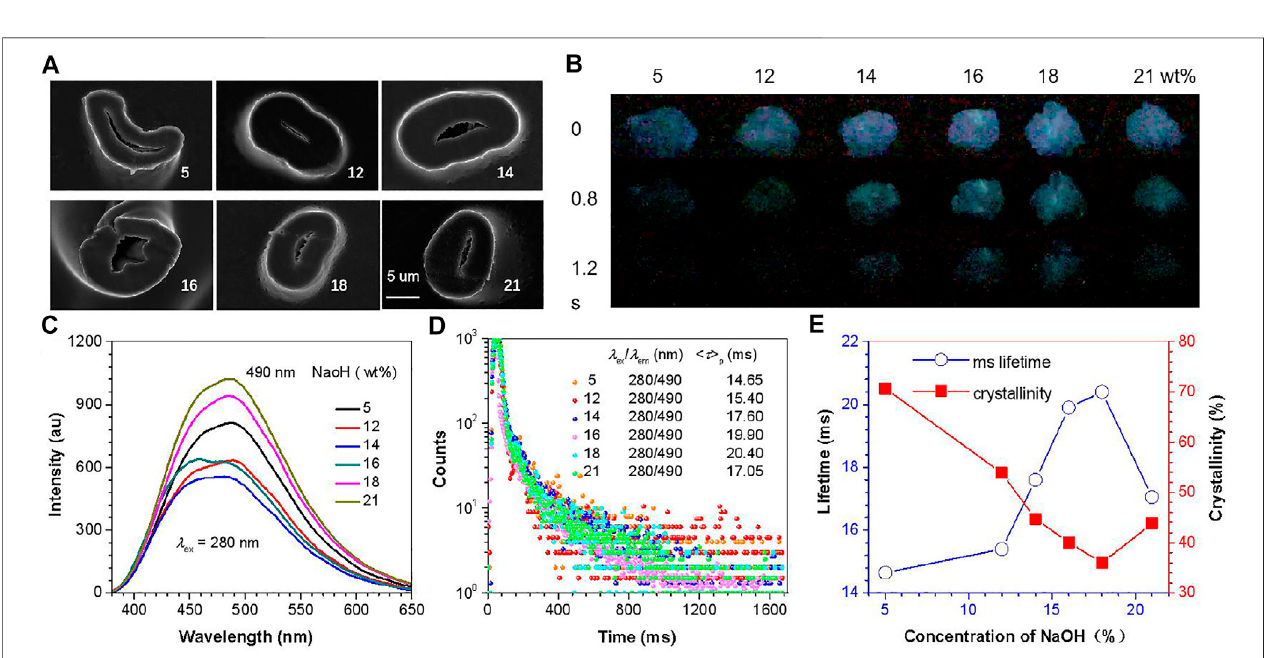
FIGURE 2 | (A) SEM images of CF cross-sections with different crystallinity (scale bar = 5 um). (B) Photographs of samples after ceasing the 254 nm irradiation at ambient conditions. (C) Phosphorescence of CF sample at excitation wavelength of 280 nm ( t d = 0.1 ms). (D) Phosphorescence ms lifetimes of different fi ber samples ( λ ex = 280 nm). (E) Change trend of ms lifetime and crystallinity of samples.